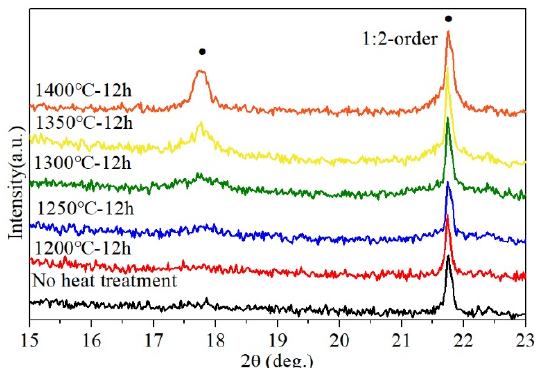
Figure 6. X-ray powder diffraction patterns (2 θ =15 ° –23 ° ) of sintered BZT ceramics by SPS at 1300 ° C and annealed BZT ceramics at different temperatures. Superlattice reflections from 1:2 order are highlighted.